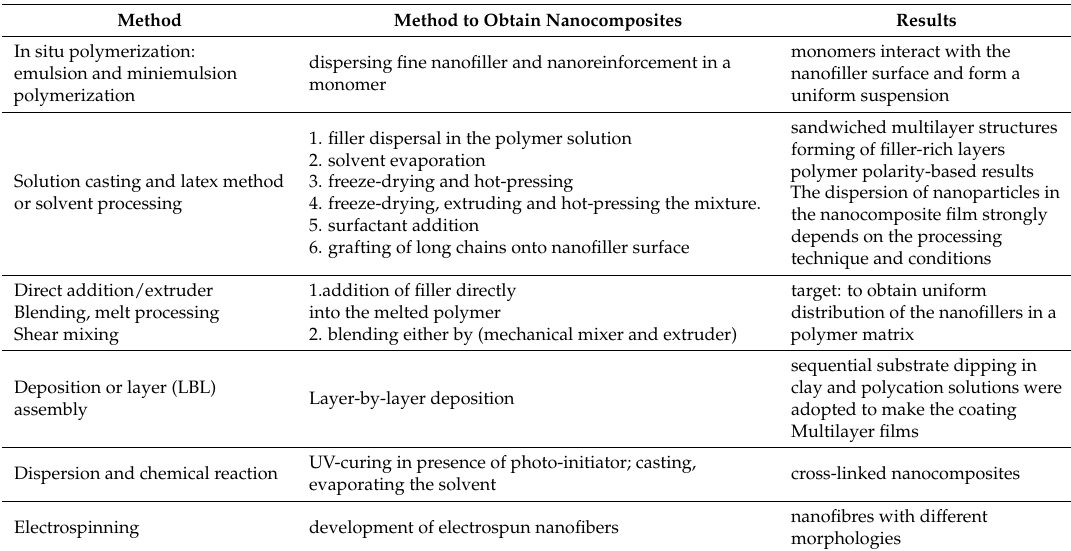
Table 1. Methods for preparation of polymer